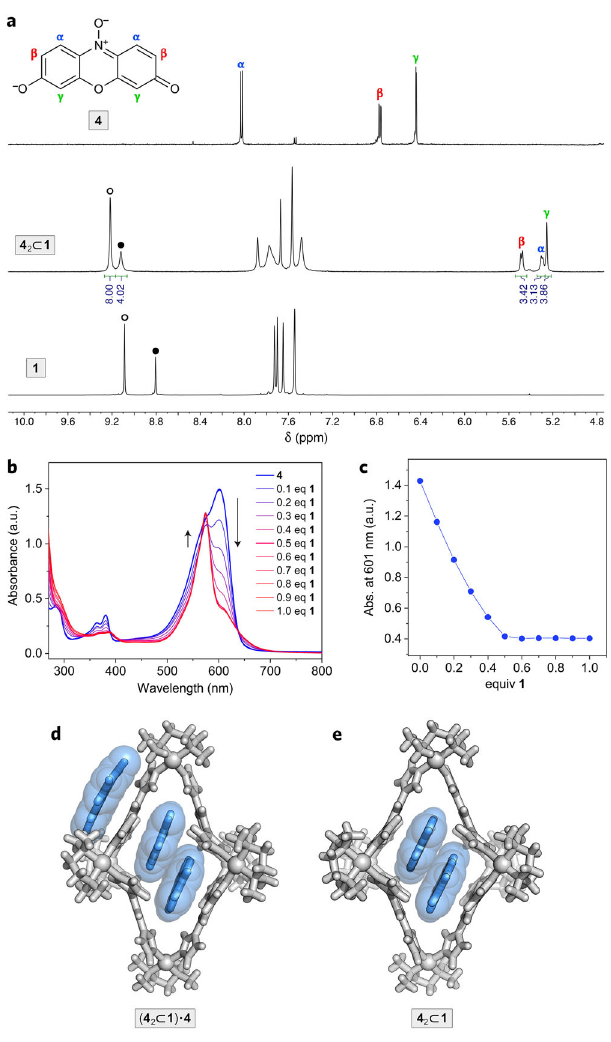
Fig. 5 Encapsulation of resazurin within coordination cage 1. a Top: Structural formula and 1 H NMR spectrum of resazurin 4 (600 MHz, D 2 O, 330 K). Center: Partial 1 H NMR spectrum of 4 2 ⊂ 1 (600 MHz, D 2 O, 330 K) (for full-range 1 H and 13 C spectra, see Supplementary Figs. 31 and 32). Bottom: Partial 1 H NMR spectrum of 1 (600 MHz, D 2 O, 330 K). b A series of UV – Vis absorption spectra accompanying the titration of 4 with a concentrated solution of cage 1 . No changes in the >400nm region are visible beyond 0.5 equiv of 1 , indicating a 2:1 stoichiometry of the complex. c Decrease of absorbance at 601 nm (high for 4 ; low for 4 2 ⊂ 1 ) as a function of the amount of 1 added. d Crystal structure of 4 2 ⊂ 1 co-crystallized with 1 equiv of unencapsulated 4 ; i.e., ( 4 2 ⊂ 1 ) ⋅ 4 . e Crystal structure of 4 2 ⊂ 1 . Nitrate counterions and water molecules were omitted for